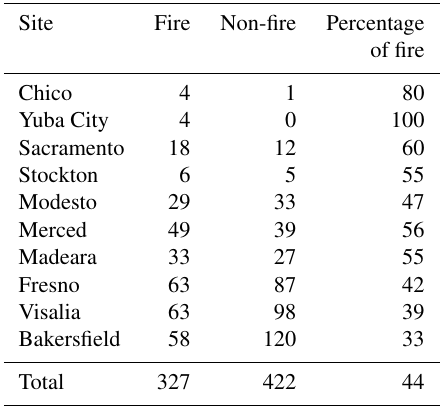
Table C4. Number and percentage of the exceedances of 70ppb MDA8 O 3 at each